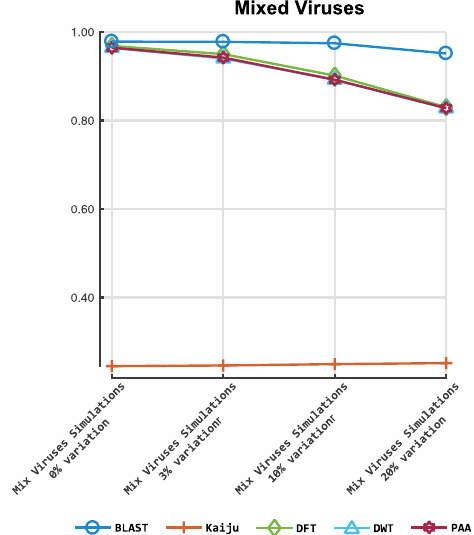
Figure 4. Accuracy of our prototype classification implementation and two established tools on mixed viruses simulated datasets. The y -axis indicates the F -measure score, and the x -axis depicts the reads data files. The plot depicts the F -measures obtained for each classifier on the mixed virus simulations. DFT: discrete Fourier transform; DWT: discrete wavelet transform; PAA: piece-wise aggregate approximation.